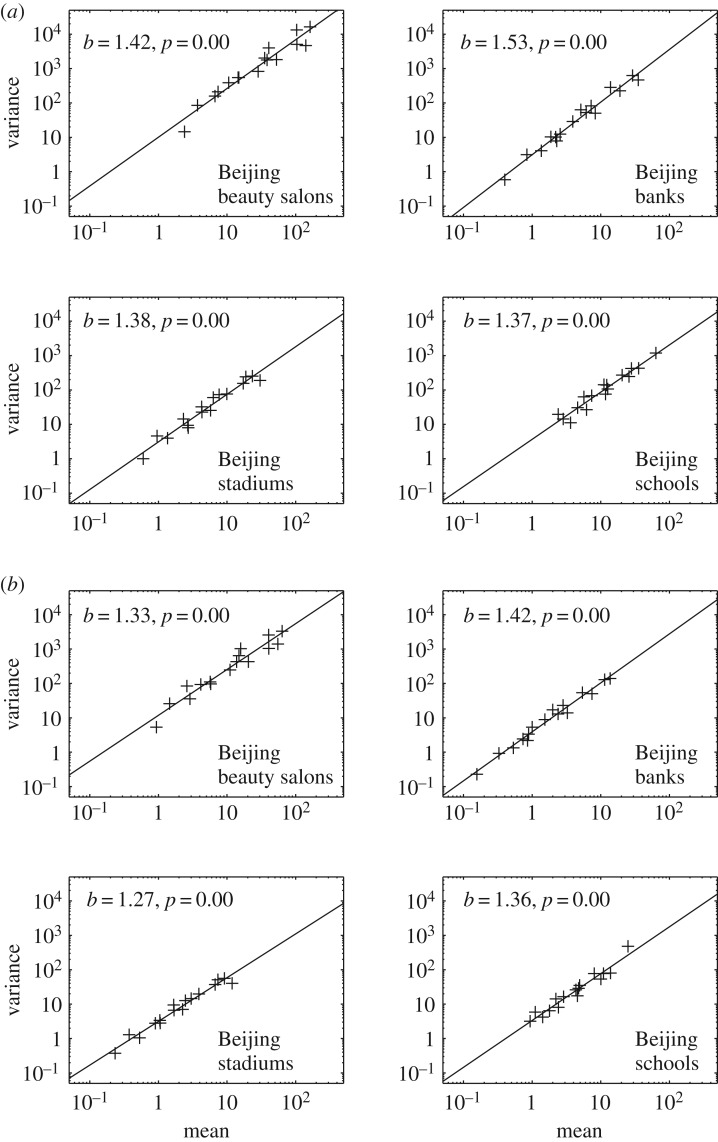
Scatter plots for beauty salons, banks, stadiums and schools in Beijing when the size of the quadrats is (a) 2000 × 2000 m (J = 5) and (b) 1250 × 1250 m (J = 8). The fitted exponent b and its p-value are included.